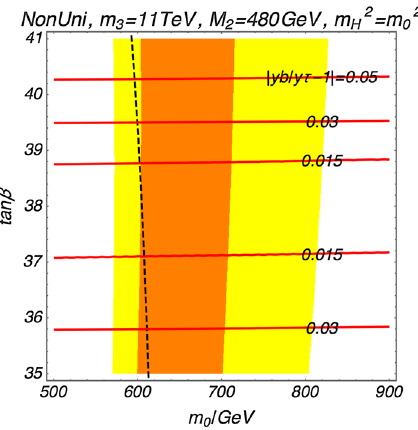
Fig. 6 The plot for the successful bottom-tau unification on the ( m 0 − tan β) plane. The red line shows the | y b / y τ − 1 | = 0 . 015 , 0 . 03 , 0 . 05. The color code is the same as Fig. 4. In most of the favored region in the figure, we have confirmed that the Higgs mass is in 124 − 126GeV and the dark matter abundance is (cid:7) h 2 (cid:4) 0 . 12 (the right side of the dotted